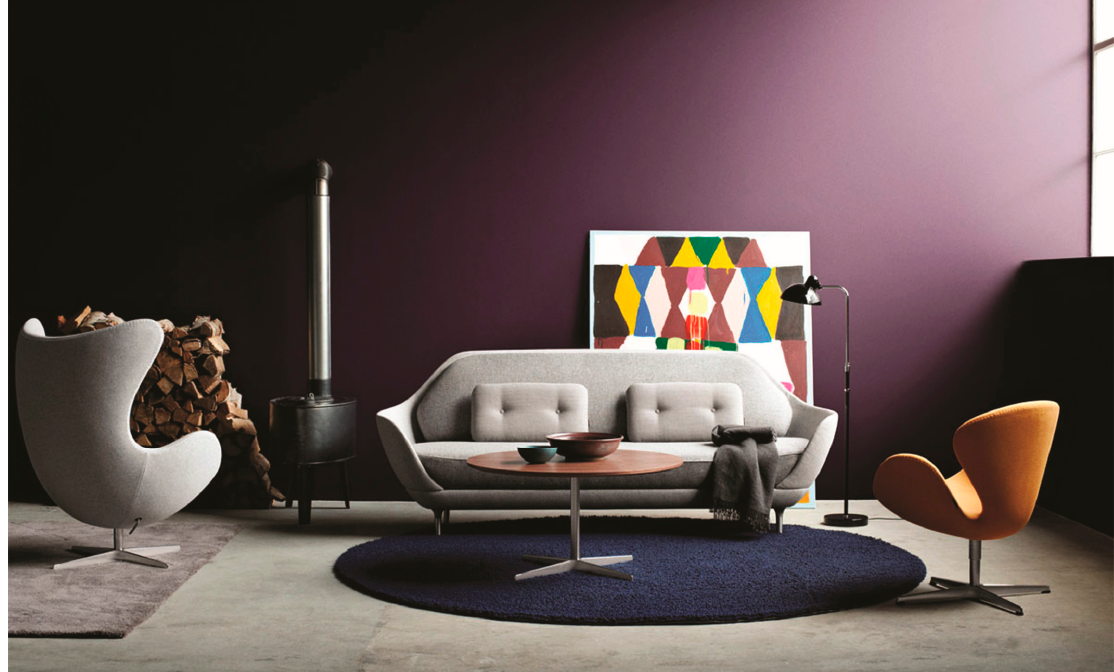
Figure 2. FAVN sofa by Jaime Hayon (2011), with Egg and Swan chairs by Arne Jacobsen